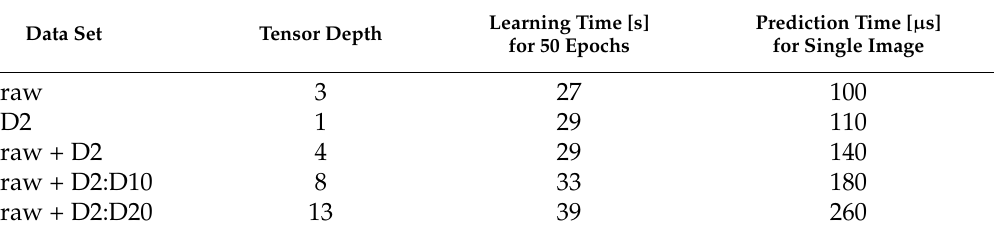
Table 8. CNN model timing for different type of input data, where raw denotes the original RGB image and Dn means Daubechies wavelet with length of n . To obtain statistically reliable results, classification time was measured for 10 5 samples and then